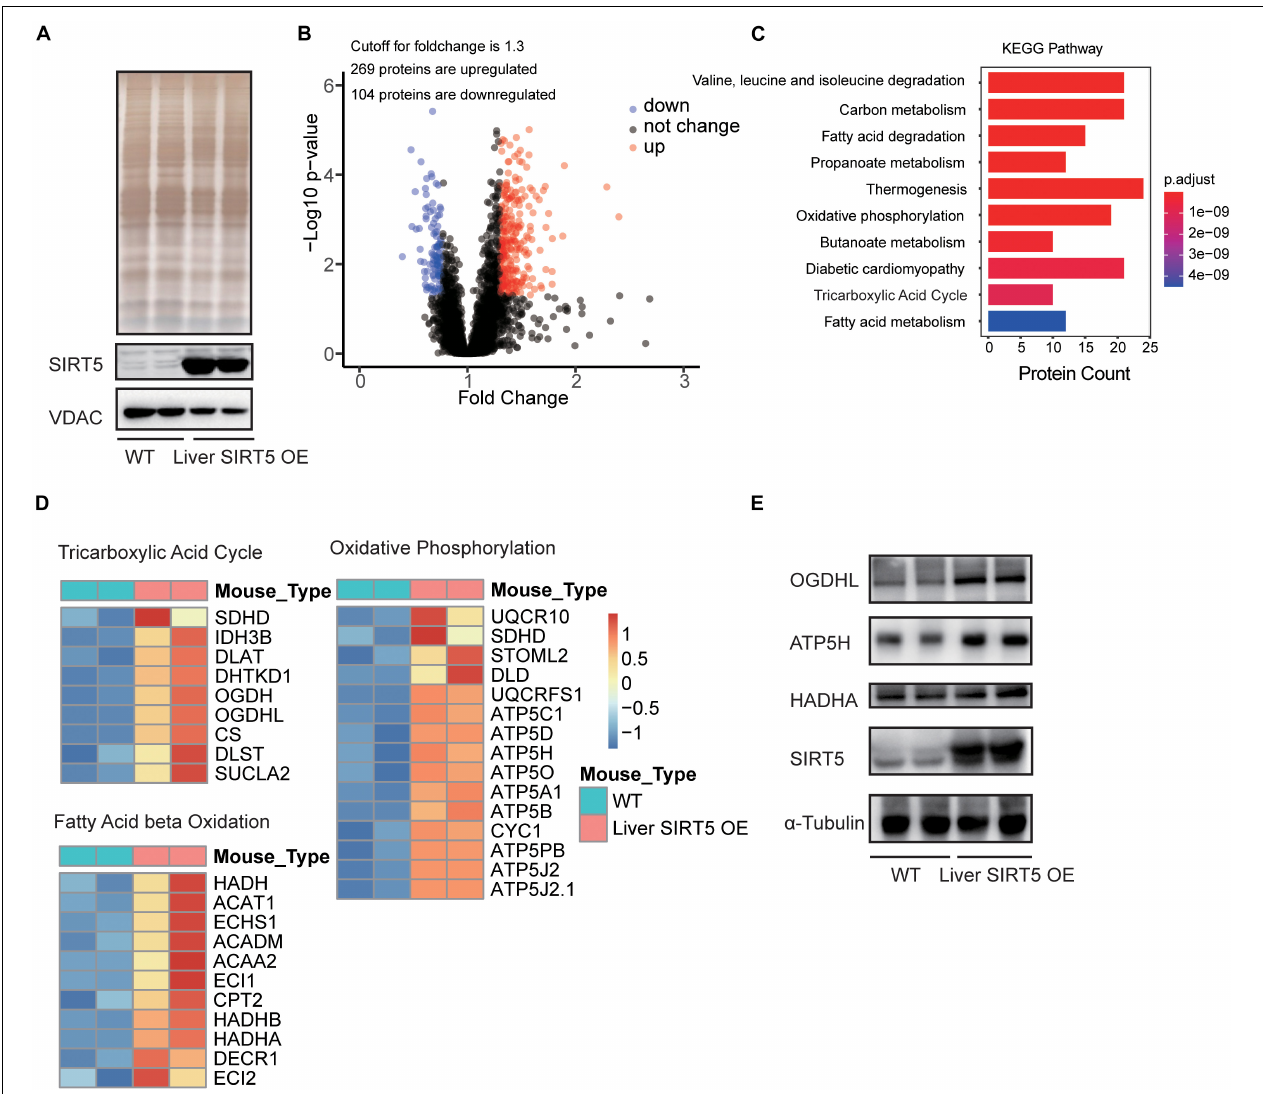
FIGURE 4 | LC-MS analysis of hepatic mitochondria between Liver SIRT5 OE and WT mice. (A) Silver staining and Western blot of hepatic mitochondrial voltage-dependent anion channel (VDAC) and SIRT5 between Liver SIRT5 OE and WT mice in fasting state ( n = 8). (B) Change distribution of peptides between Liver SIRT5 OE and WT mice. Red and blue dots indicate SIRT5 up-regulated and down-regulated peptides with the threshold of ratio (Liver SIRT5 OE/WT) ≥ 1.3 and p -value < 0.05 ( n = 8). (C) Pathway enrichment of regulated proteins. (D) Heat map of regulated proteins involved in the tricarboxylic acid cycle, the fatty acid β -oxidation, and the oxidative phosphorylation. Blue or red colors represent downregulated or upregulated proteins, respectively ( n = 8). (E) Western blot analysis of OGDHL, HADHA, and ATP5H and in Liver SIRT5 OE and WT mice ( n =